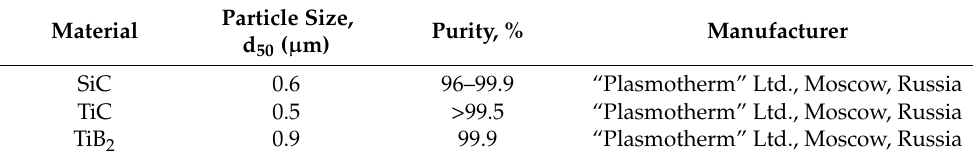
Table 2. Raw materials information.